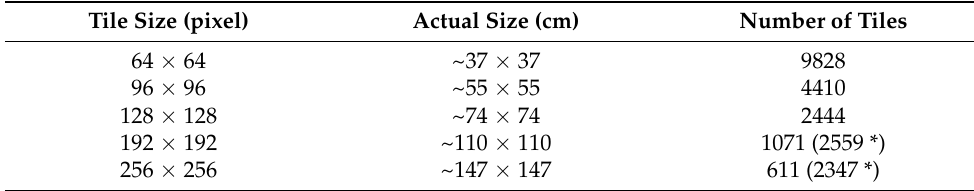
Table 3. Number of tiles generated from Pick Pit orthomosaic for each image tile size. Tile Size (pixel) Actual Size (cm) Number of Tiles 64 × 64 ~37 ×